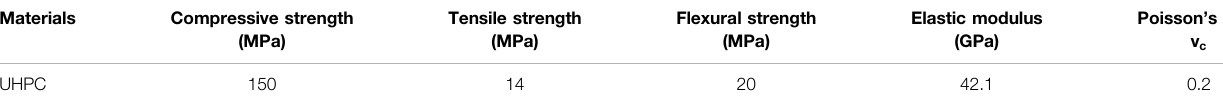
TABLE 2 | Mechanical properties of